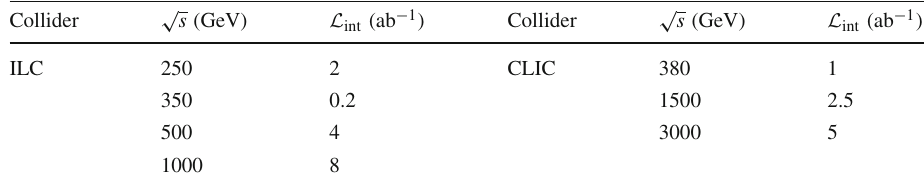
Fig. 16 The projected (left) 95% exclusion limit and (right) a 5 σ discovery reach in the m ˜ χ 0 various decay modes are as in Fig.